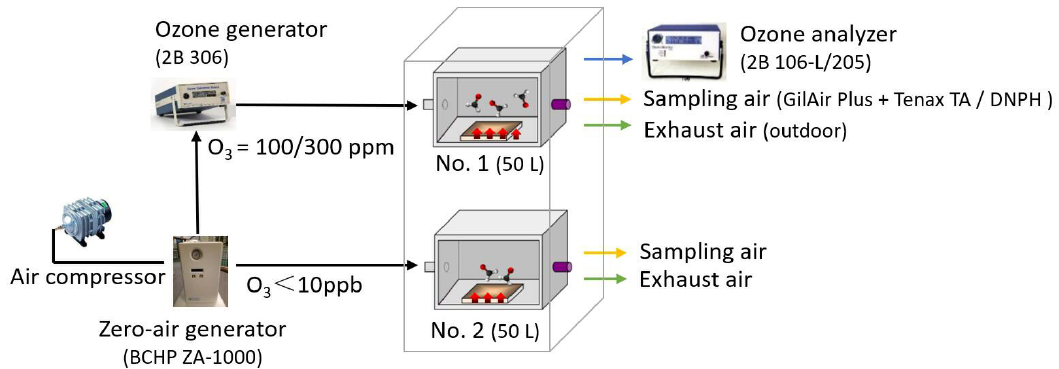
Figure 2. Schematic diagram of the laboratory apparatus for measuring ozone deposition and volatile organic compound (VOC) emissions rates.